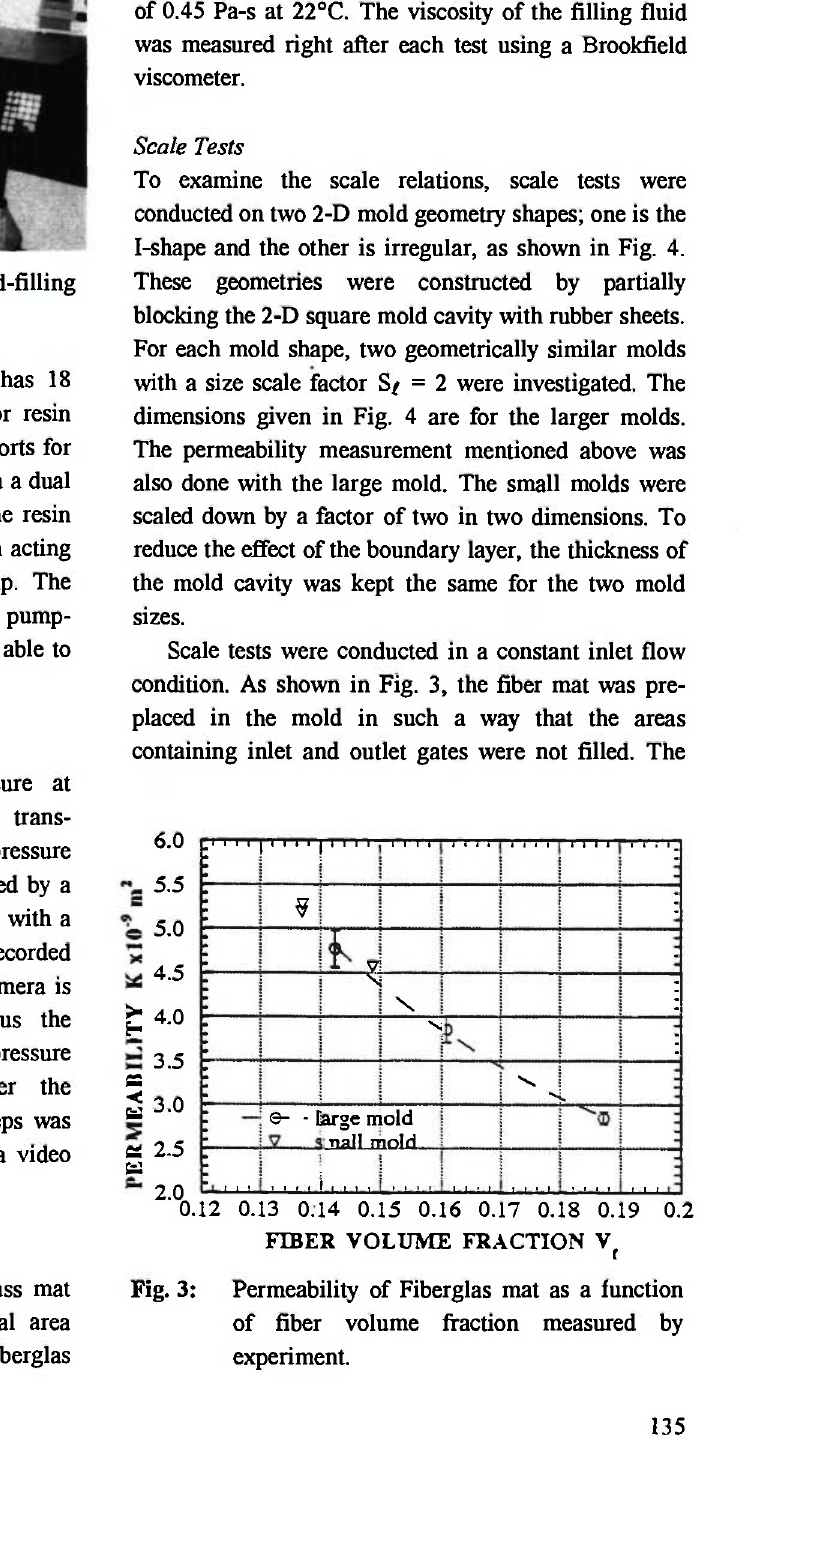
Fig. 3: Permeability of Fiberglas mat as a function of fiber volume fraction measured by